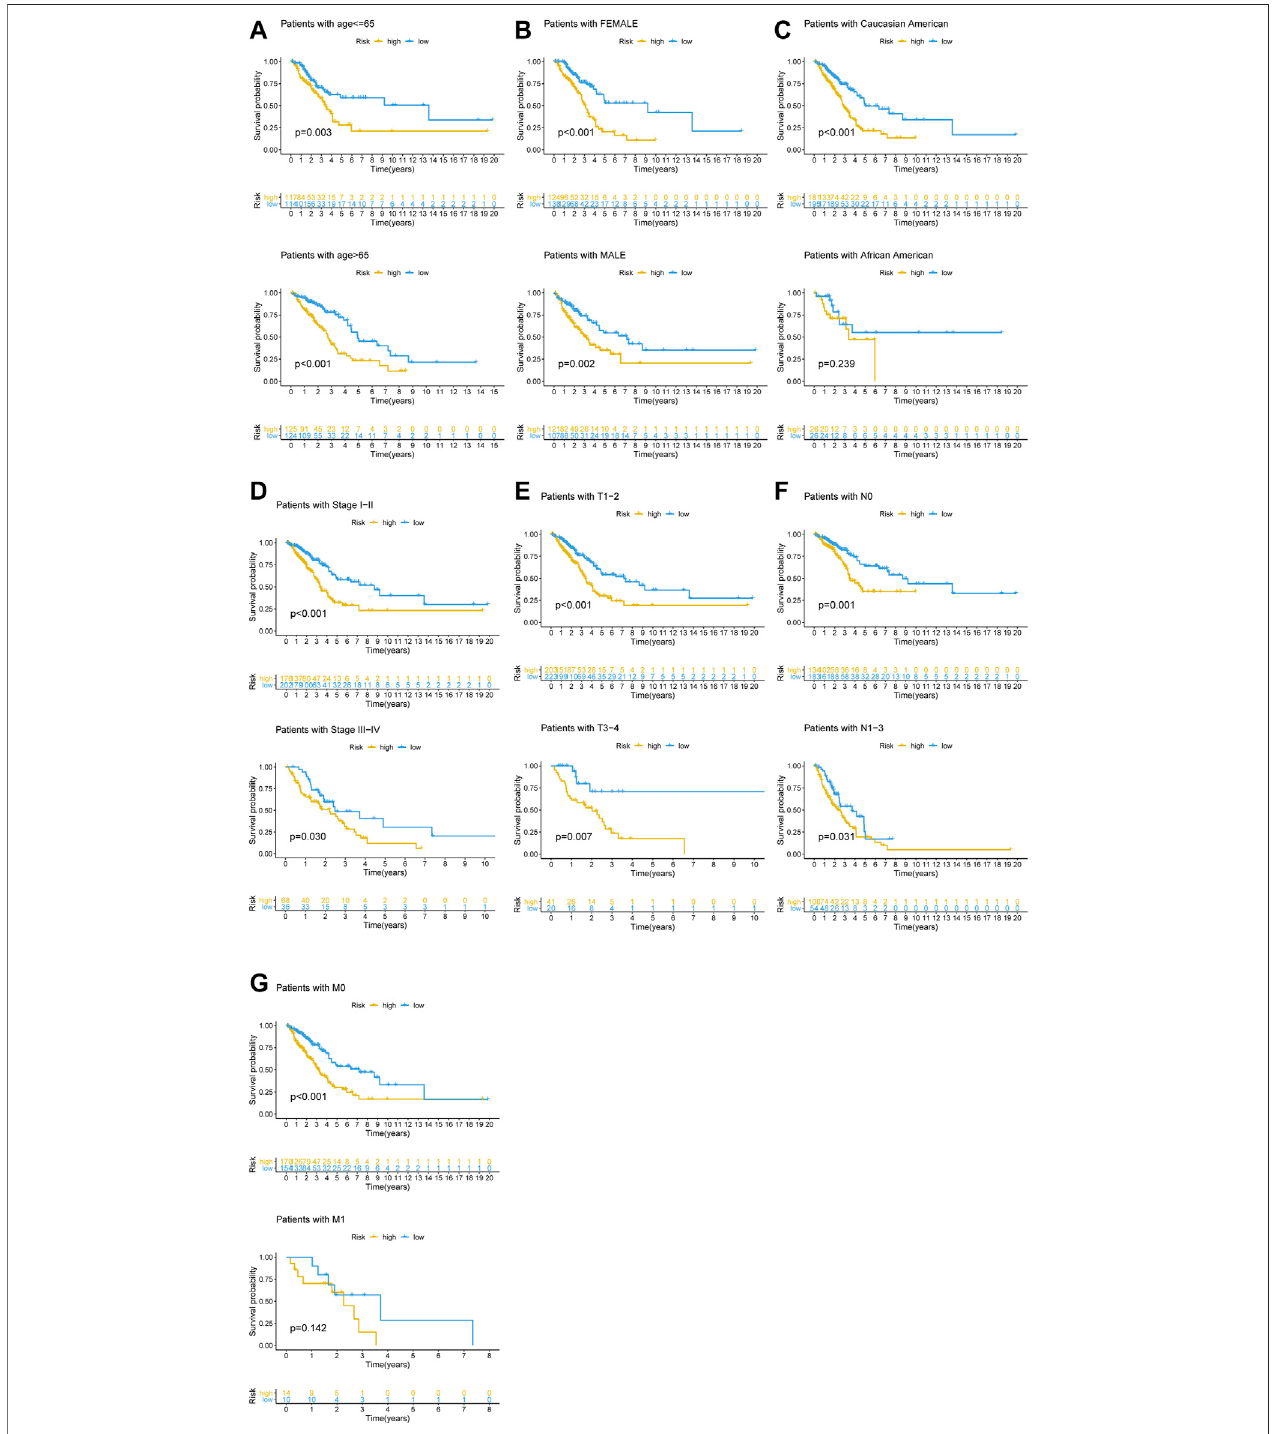
FIGURE 5| Kaplan – Meier analysis ofOS between the high-risk and low-risk groups in LUAC patients with different clinical characteristics. Kaplan – Meier curves of LUAC patientswithdifferentclinical characteristics, including (A) age( ≤ 65/ > 65); (B) gender (female/male); (C) race(Caucasian American/African American); (D) stageof lung cancer (Stage I-II/III-IV); (E) pathologic T stage (T1-2/T3-4); (F) pathologic N stage (N0/N1-3); (G) pathologic M stage (M0/M1).